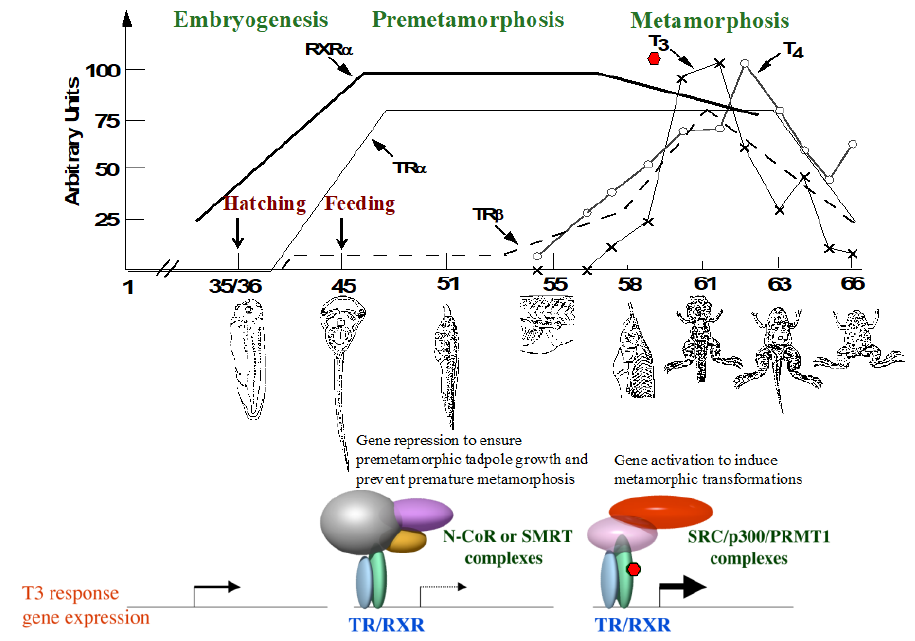
Figure 2. TR function during frog development. ( Top ). Correlations of plasma T 3 and T 4 and mRNA levels of TR α , TR β , and RXR α with Xenopus laevis development. The embryos hatch around stage NF35, and a feeding stage tadpole is formed by stage NF45. Note that the expression of TR α (solid line) and RXR α (bold line) is activated to high levels when tadpole feeding begins, while high levels of T 3 /T 4 and TR β mRNA (broken line) are present only during metamorphosis. ( Bottom ). Regulation of T 3 -inducible genes in frog development. During embryogenesis, there is little T 3 /T 4 or TR expression, and TR target genes are expressed at basal levels independent of TRs or T 3 /T 4 . During premetamorphosis between stage NF45 but before stage NF54 when there is little T 3 /T 4 present, the expression of TRs, mainly TR α and RXRs, causes repression of the genes due to the binding of the TR target genes by unliganded TR/RXR heterodimers that recruit corepressor complexes. The synthesis of endogenous T 3 /T 4 after stage NF54 leads to formation of liganded TRs that recruit coactivator complexes for the activation of target genes and